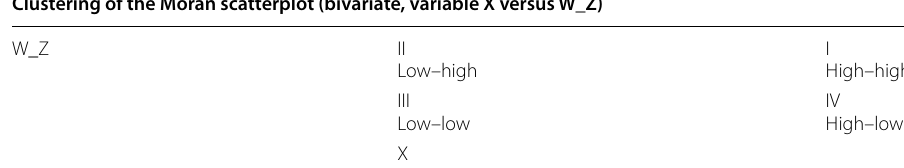
Source: Anselin and Rey (2014)